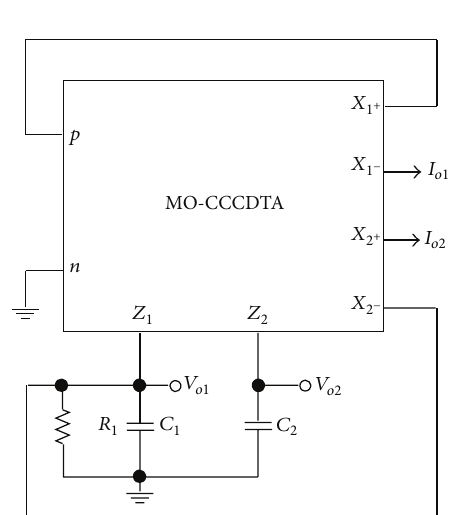
Figure 2: The proposed current-mode and voltage-mode quadra- ture